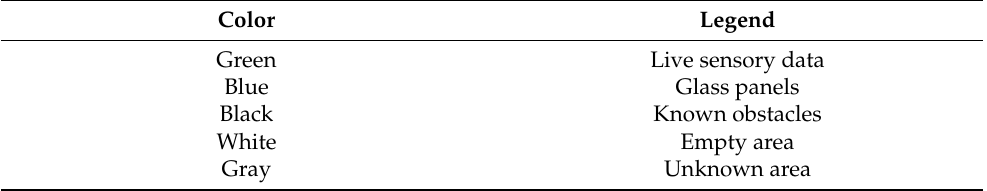
Table 6. OGM color legend